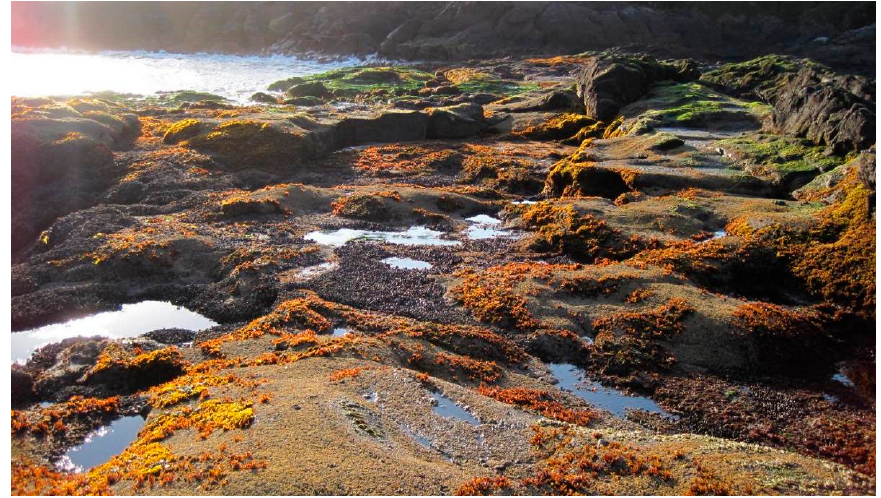
Figure 10. An image at the Rabbit Rock site showing the undulating rock and pooled water conditions. ISPRS Int. J. Geo-Inf. 2020 , 9 , x FOR PEER REVIEW